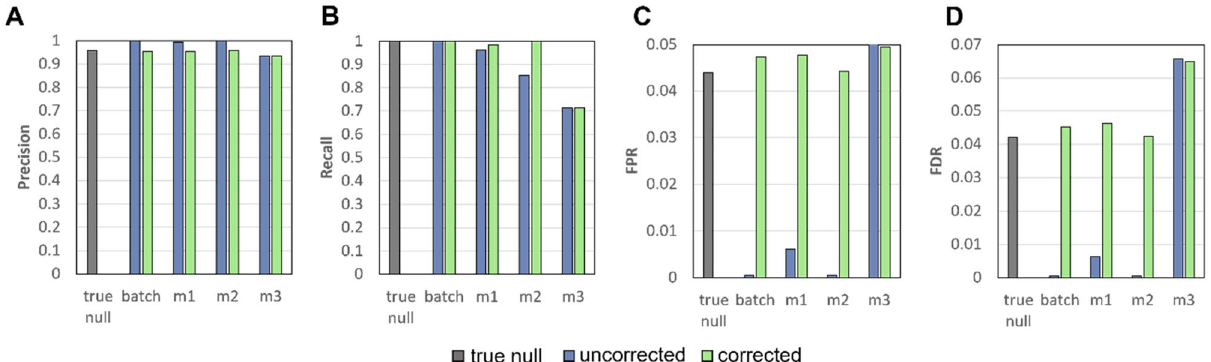
Figure 9. Performance Metrics for Genomics Simulation reveal that M2 performs the best among post MVI data. Higher values indicate better performance: ( A ) Precision ( B ). Recall. Lower values indicate better performance: ( C ) False Positive Rate (FPR) ( D ) False Discovery Rate